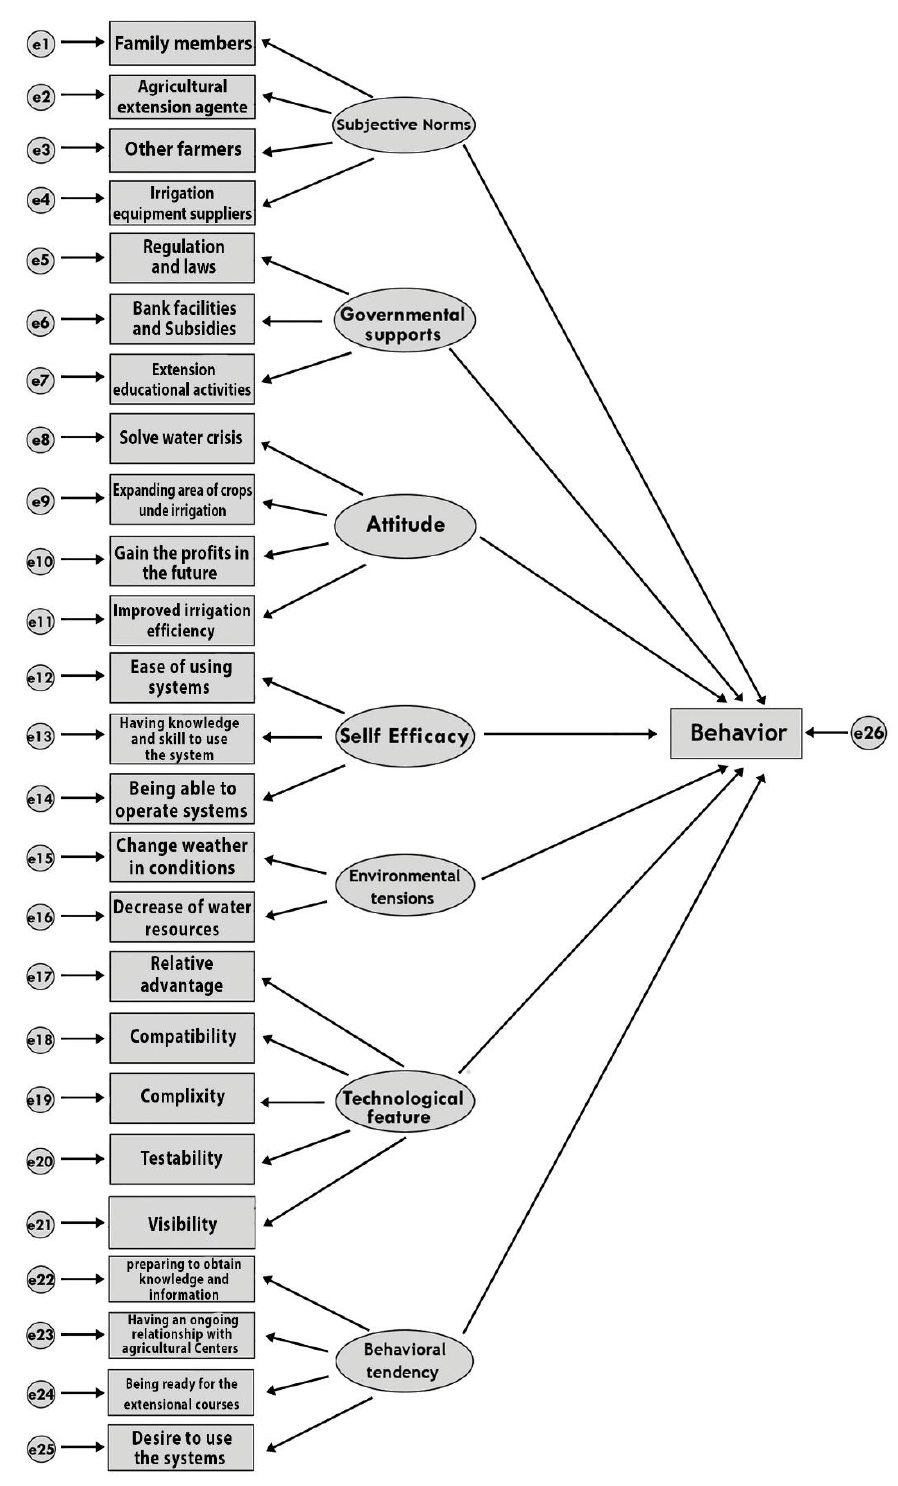
Figure 1. The conceptual model of the behavior of using PISs of farmers.